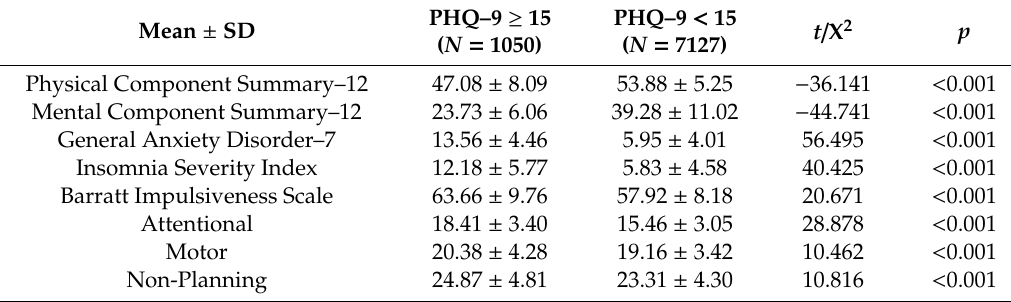
Table 2. Comparison of clinical characteristics (anxiety, sleep, impulsivity and quality of life) according to the presence of moderate–severe depressive symptomatology into student subgroup.